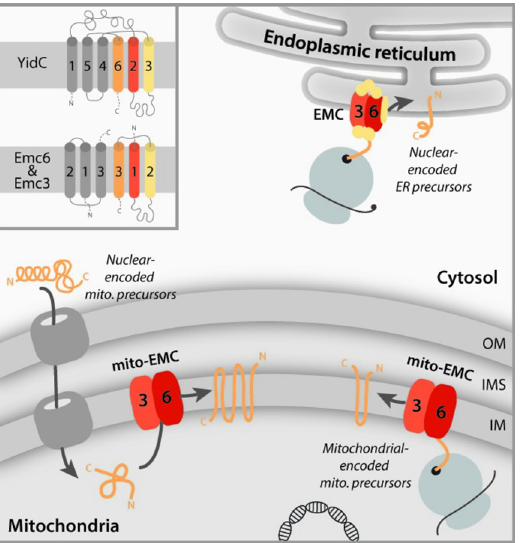
Fig 1. The core members Emc3–Emc6 of the ER insertase EMC can functionally replace the mitochondrial inner membrane insertase Oxa1. Oxa1 mediates insertion of nuclear-encoded precursor proteins that are imported from the cytosol as well as mitochondrial-encoded precursors, which are exported from the matrix side. Both functions were maintained in oxa1 Δ cells when an Emc3–Emc6 fusion protein was targeted to the inner mitochondrial membrane (mito-EMC). In the inset, the topology of Escherichia coli YidC and the EMC subunits Emc6 (left) and Emc3 (right) are shown [4]. Conserved transmembrane helices of the Oxa1 superfamily are highlighted in color. EMC AU : AnabbreviationlisthasbeencompiledforthoseusedinFig 1 : Pleaseverifythatallentriesarecorrect : , ER membrane complex; ER, endoplasmic reticulum; IM AU : PleasedefineIM ; IMS ; andOMinFig 1 abbreviationlistiftheseareabbreviations : , inner membrane; IMS, intermembrane space; OM, outer membrane.